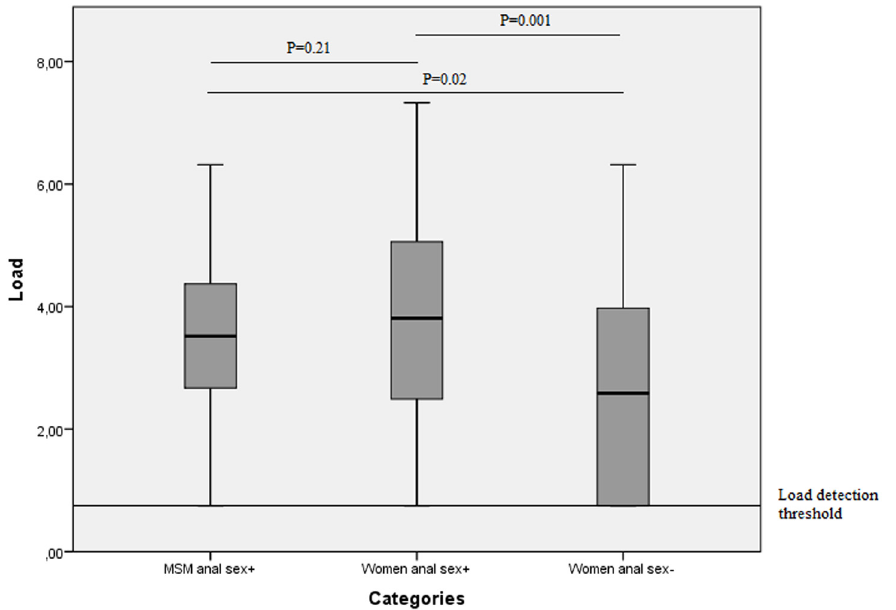
Fig 1. Log-transformed number of cycle threshold per millilitre (Ct/ml) (load) in MSM, women who reported anal sex and women who did not report anal sex, including load detection threshold, geometrical mean and mean difference between groups tested by univariate linear regression